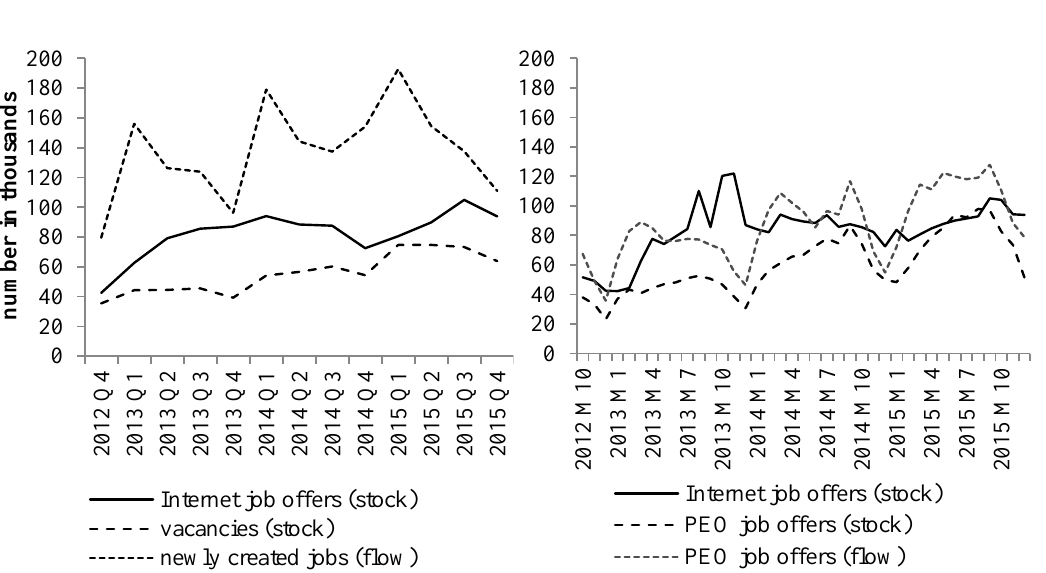
Figure 2 : Internet job offers, job offers from public employment offices (PEO), vacancies, and newly created jobs (in